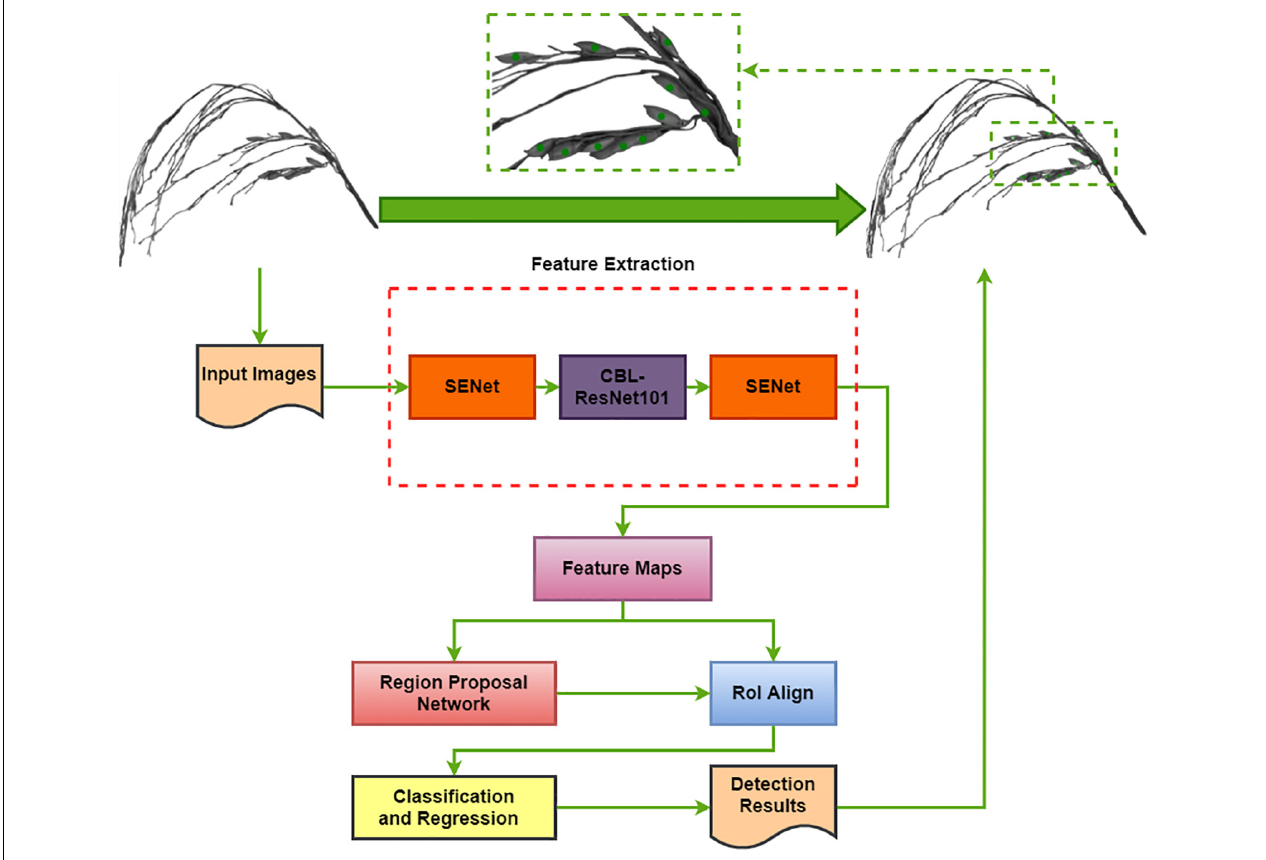
FIGURE 5 | Block diagram of the TPanicle-RCNN model. The dotted red rectangles indicate the model improvements.